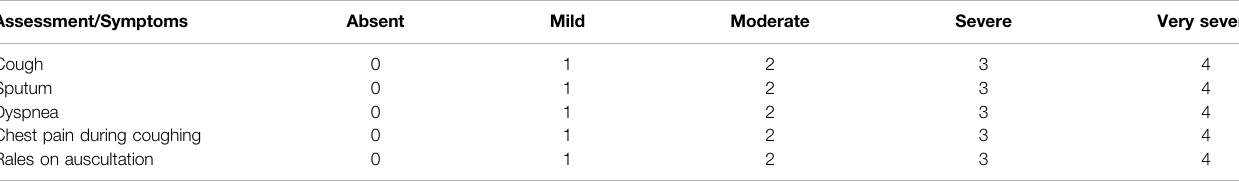
TABLE 2 | Bronchitis severity score